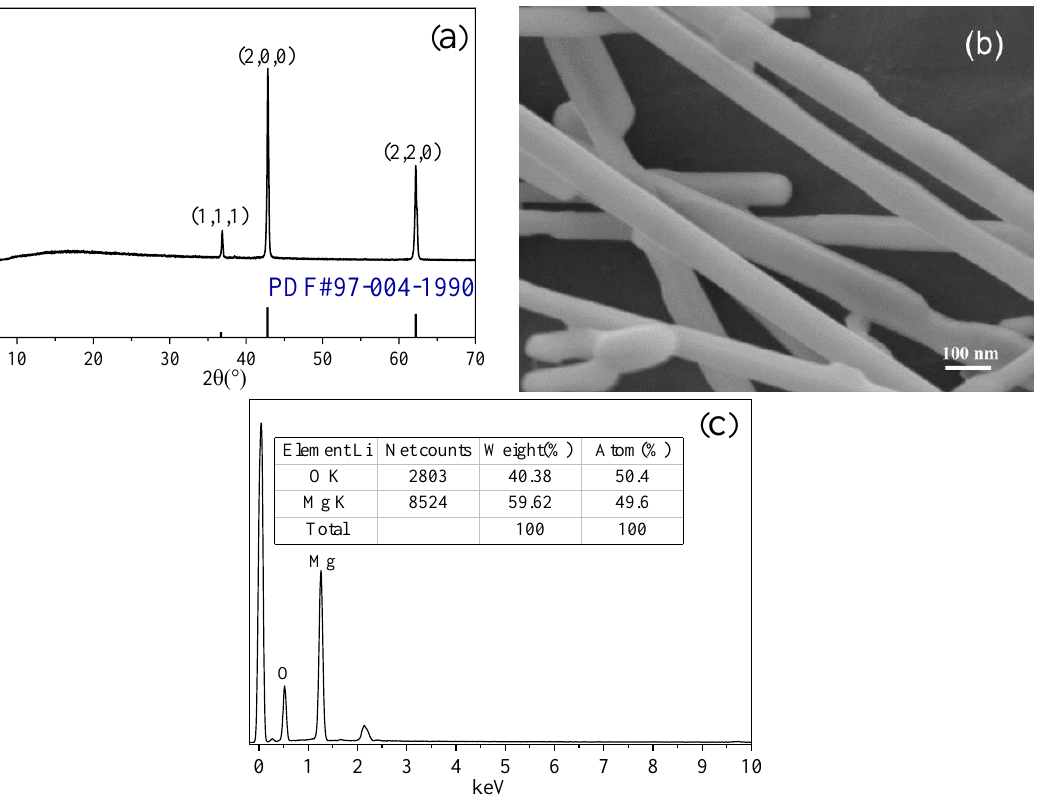
Figure 13. XRD pattern ( a ), SEM image ( b ), and corresponding EDS spectrum ( c ) of the MgO whisker.